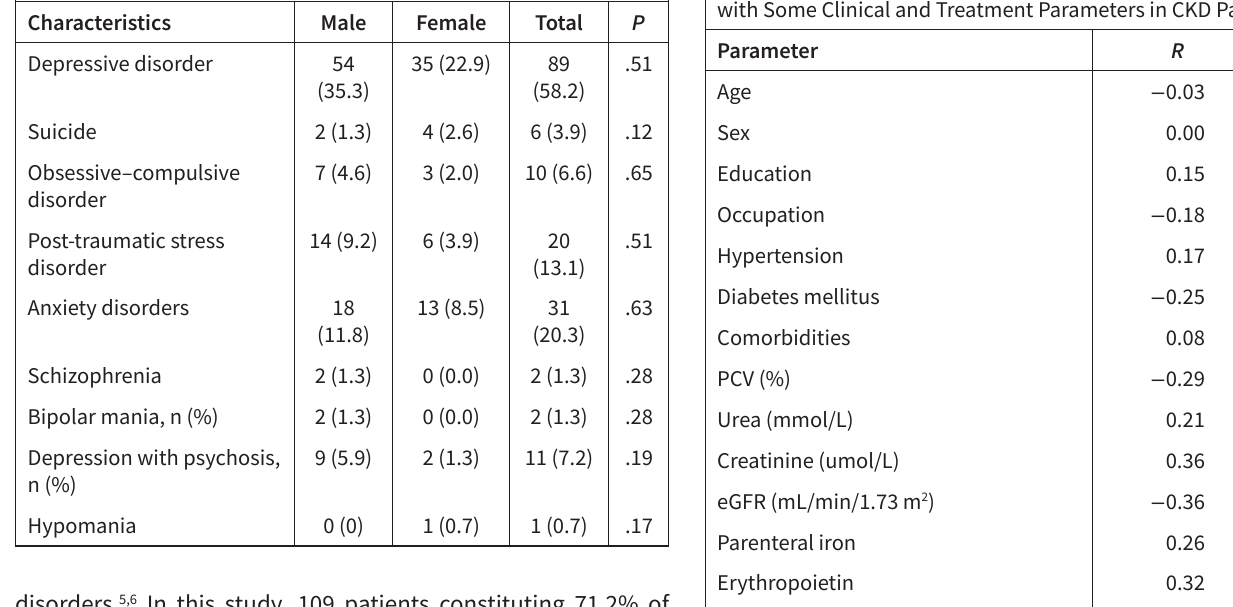
Table 5. Pearson’s Correlations of Neuropsychiatric Manifestation with Some Clinical and Treatment Parameters in CKD